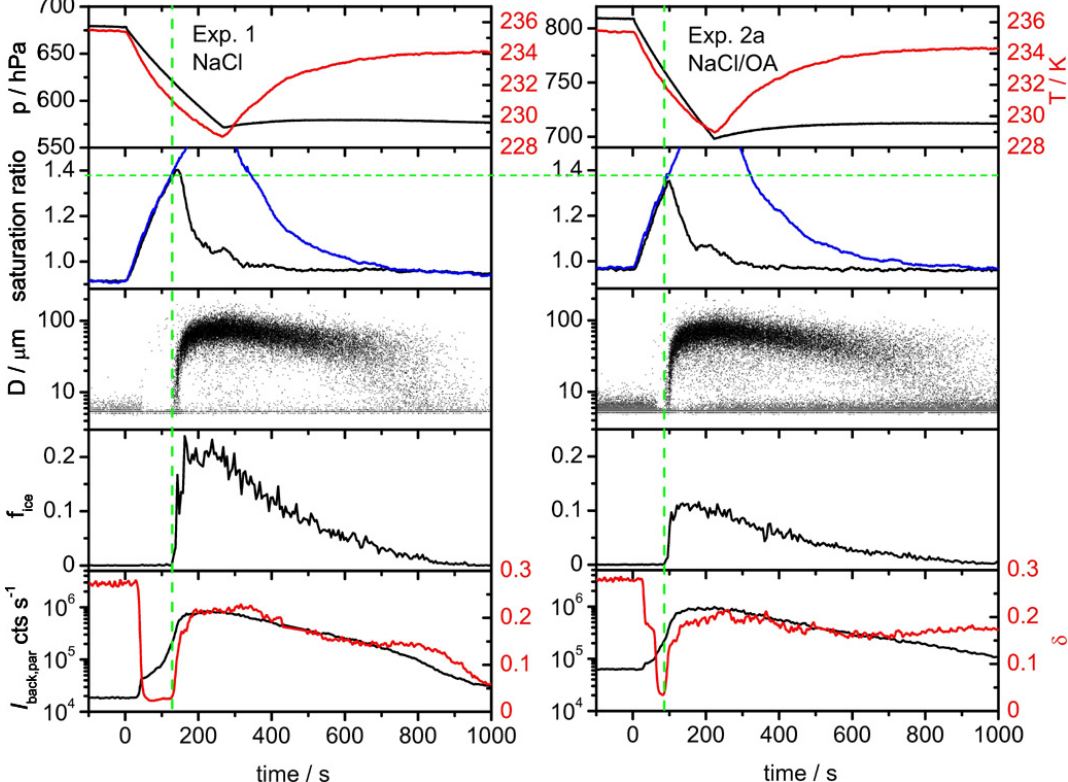
Fig. 7. Time series of various AIDA records during the second expansion cooling cycles from Exp. 1 and Exp. 2a that were started at 235K. Time zero again denotes the start of pumping and corresponds to the time stamp of the last records in the respective time series of the depolarisation ratio that are shown in Fig. 6. The individual panels contain the same measurements as in Fig. 5. In order to elucidate the subtle differences in the critical ice saturation ratio between the two experiments, the traces for S liq are omitted to show the recorded ice saturation ratios on an enlarged y-axis scale in the second row panels. Except for the top-row panels, all y-axes of adjacent panels are identically